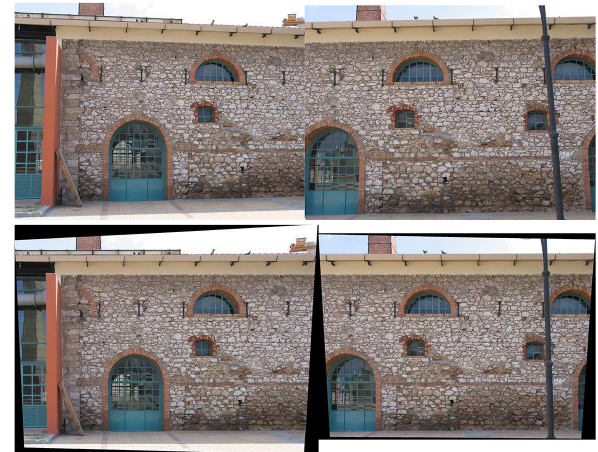
Figure 9. Final rotated images of the above pair (image axes convergence of 10º).